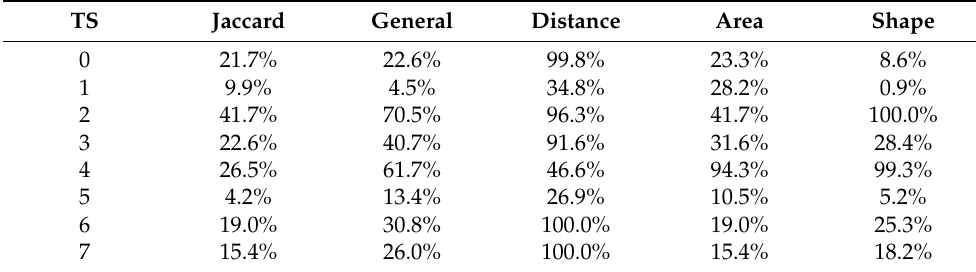
Figure 10. Results for Traffic Light/Sign Recognition. Evaluation for traffic lights should focus only on the distance measure output in a situation when results of shape and area similarity are very low since there is no practical advantage of the whole case detection as long as the correct state of light is recognized. Table 3. Rectangular similarity and Jaccard index for traffic signalization and traffic signs detected in Figure